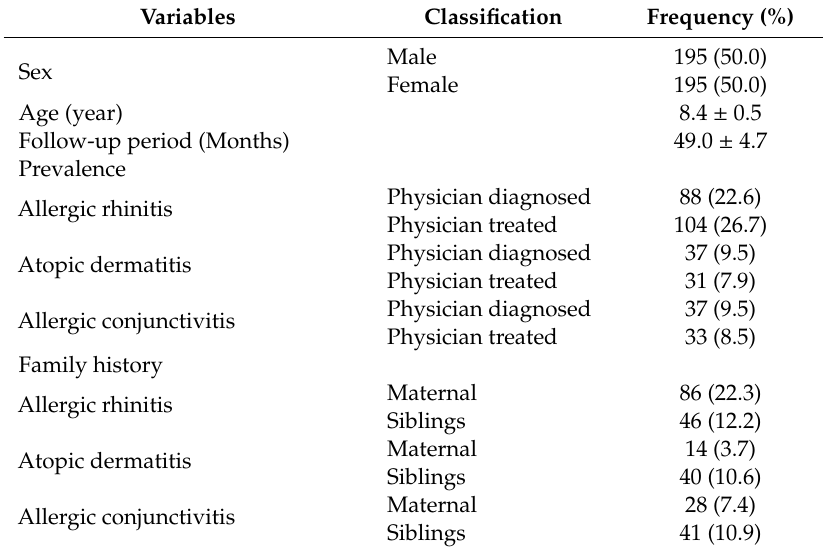
Table 1. General characteristics of the subjects at the first survey ( n =